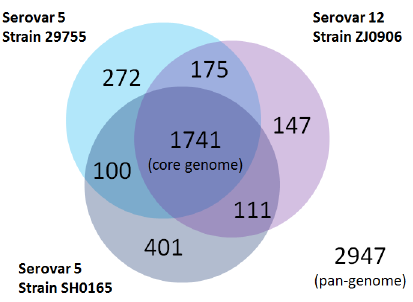
Figure 2. Pan-genome of H.parasuis strains ZJ0906, SH0165 and 29755. The Venn diagram was not drawn in proportion and aims only for illustration of pan-genome and distribution of core genes. Circles denote genomes, overlapping region between circles denote genes shared with respective genomes. Numeral figures within respective regions denote the number of genes found therein.